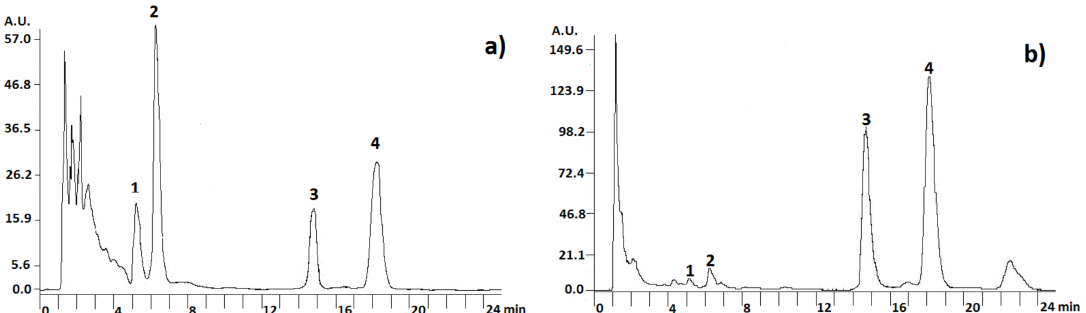
Figure 2. Guayulins A, B, C and D in resin extracts from ( a ) Guayule leaves (sample L1, extraction solvent: acetone) and ( b ) Guayule coarse stems (sample CS2, extraction solvent: ethanol). Peak